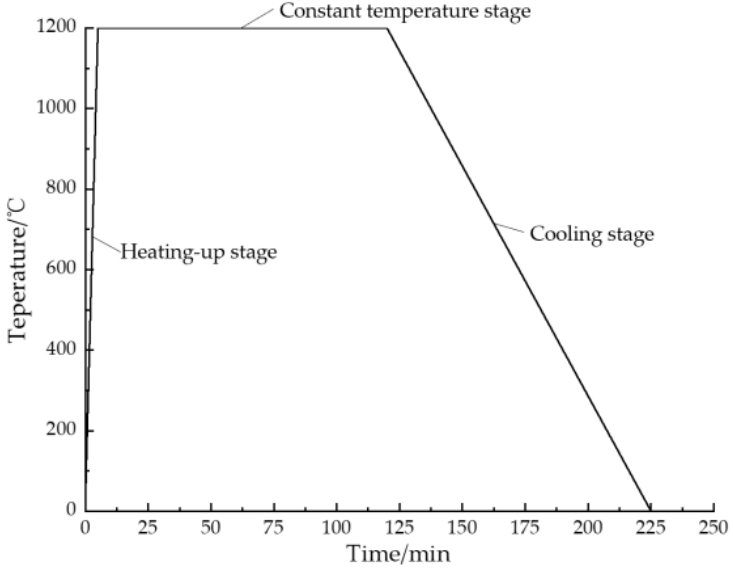
Figure 3. RABT tunnel fire heating curve.